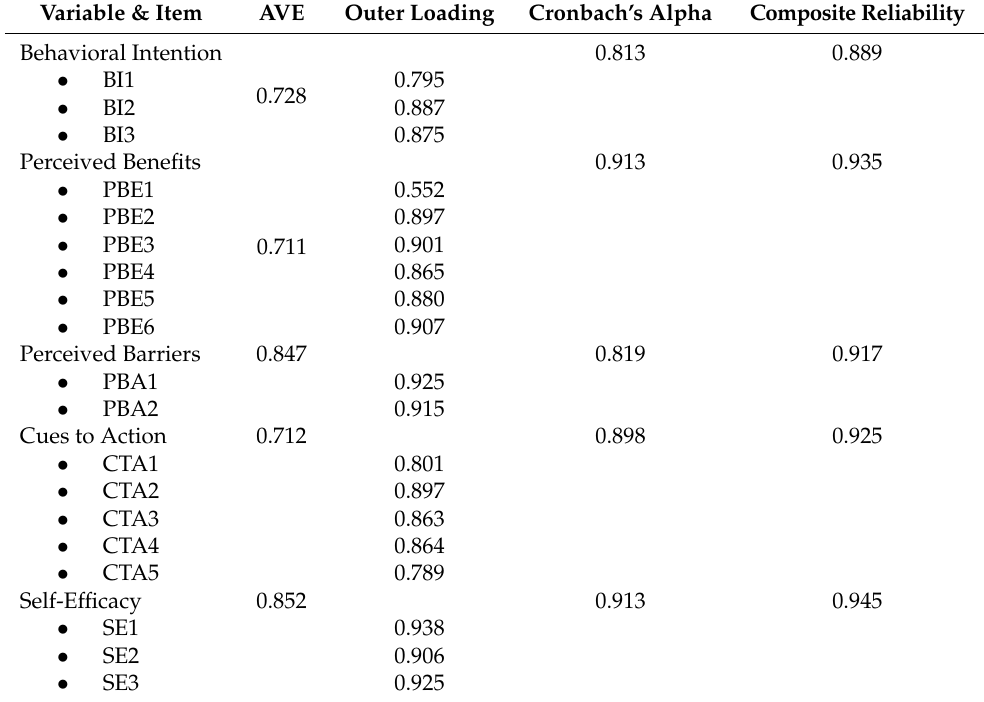
Table 1. PLS-Algorithm.